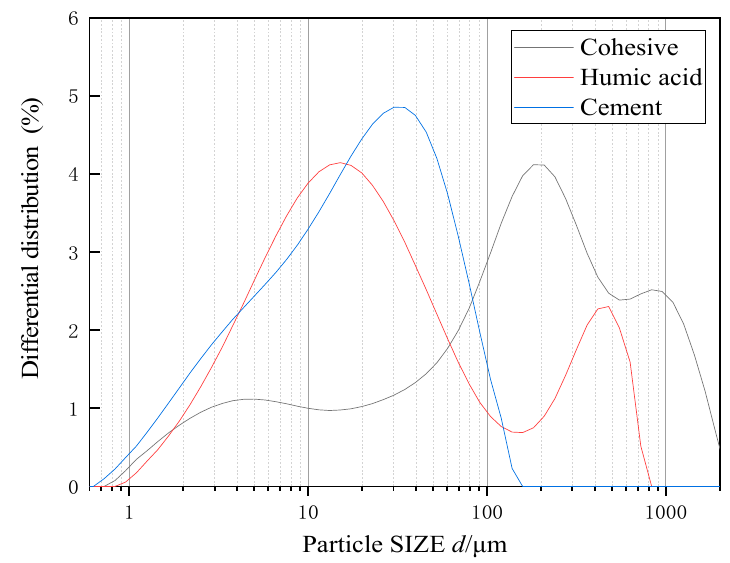
Figure 2. Particle distribution curve of the test materials.